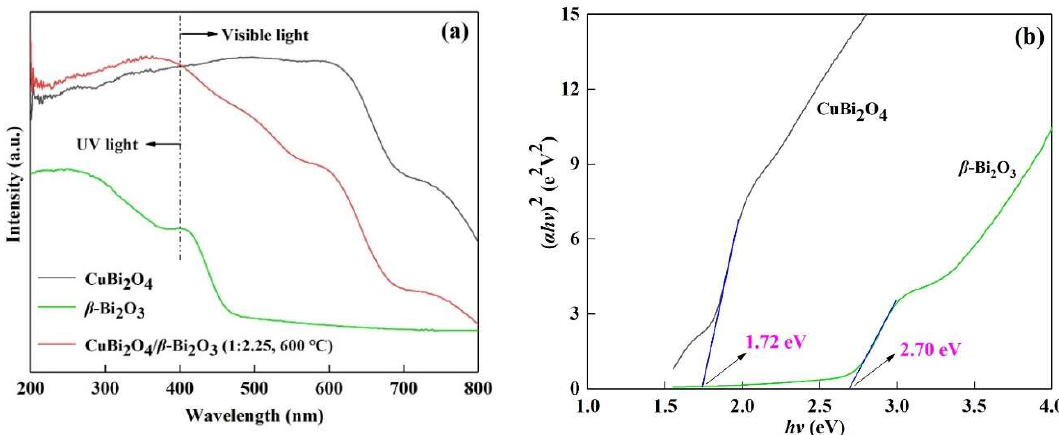
Figure 4. ( a ) Ultraviolet-visible (UV-Vis) diffuse reflectance spectra of CuBi 2 O 4 and CuBi 2 O 4 / β -Bi 2 O 3 (1:2.25, 600 °C); ( b ) band gap energy ( E g ) of CuBi 2 O 4 and CuBi 2 O 4 / β -Bi 2 O 3 (1:2.25, 600 °C) derived from the plots of ( αhv ) 2 versus energy ( hv ).